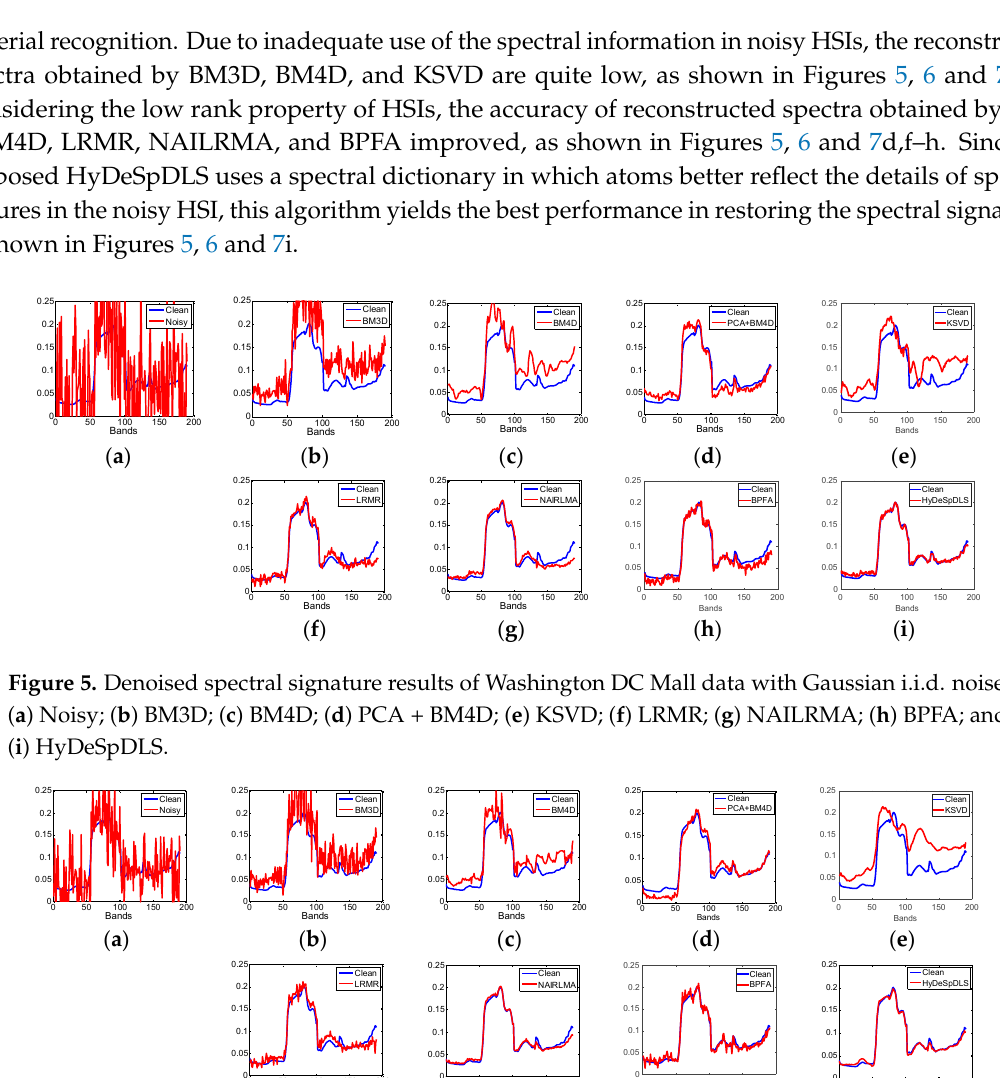
Figure 4. Denoising results for band 60 of Washington DC Mall data with Poissonian noise: ( a ) Clean image; ( b ) zoomed area of clean image in red box of ( a ); ( c ) noisy image; ( d ) BM3D; ( e ) BM4D; ( f ) PCA + BM4D; ( g ) KSVD; ( h ) LRMR; ( i ) NAILRMA; ( j ) BPFA; and ( k ) HyDeSpDLS.